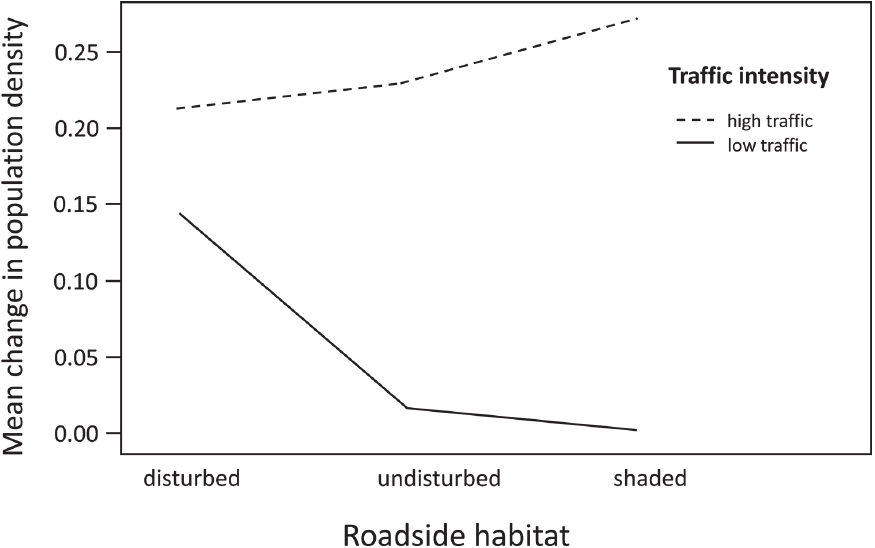
Figure 4. Mean change in population density of Ambrosia artemisiifolia between subsequent years in in- vaded road corridors with different traffic intensities. High traffic is merged from the corridor types a-road and state road, low traffic is merged from district road and parish road. Mean values are based on road cell specific population density categories (n = 303994 road cells in the road network).